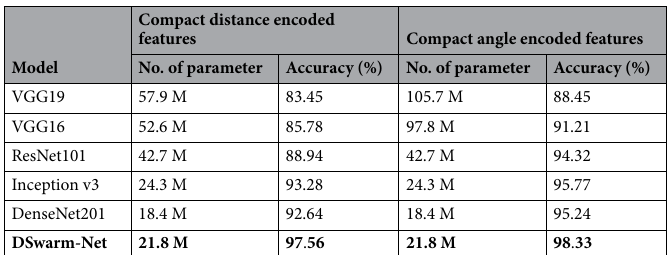
Table 3. Comparison in terms of the number of parameters and the classification accuracy of the proposed model with other CNN models on UTD-MHAD dataset.